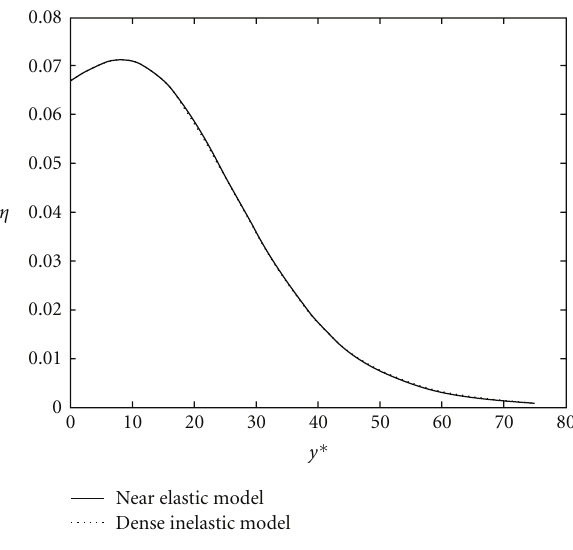
Figure 3: Comparison of packing fraction for near elastic model and dense inelastic models for V ∗ = 6 . 0.